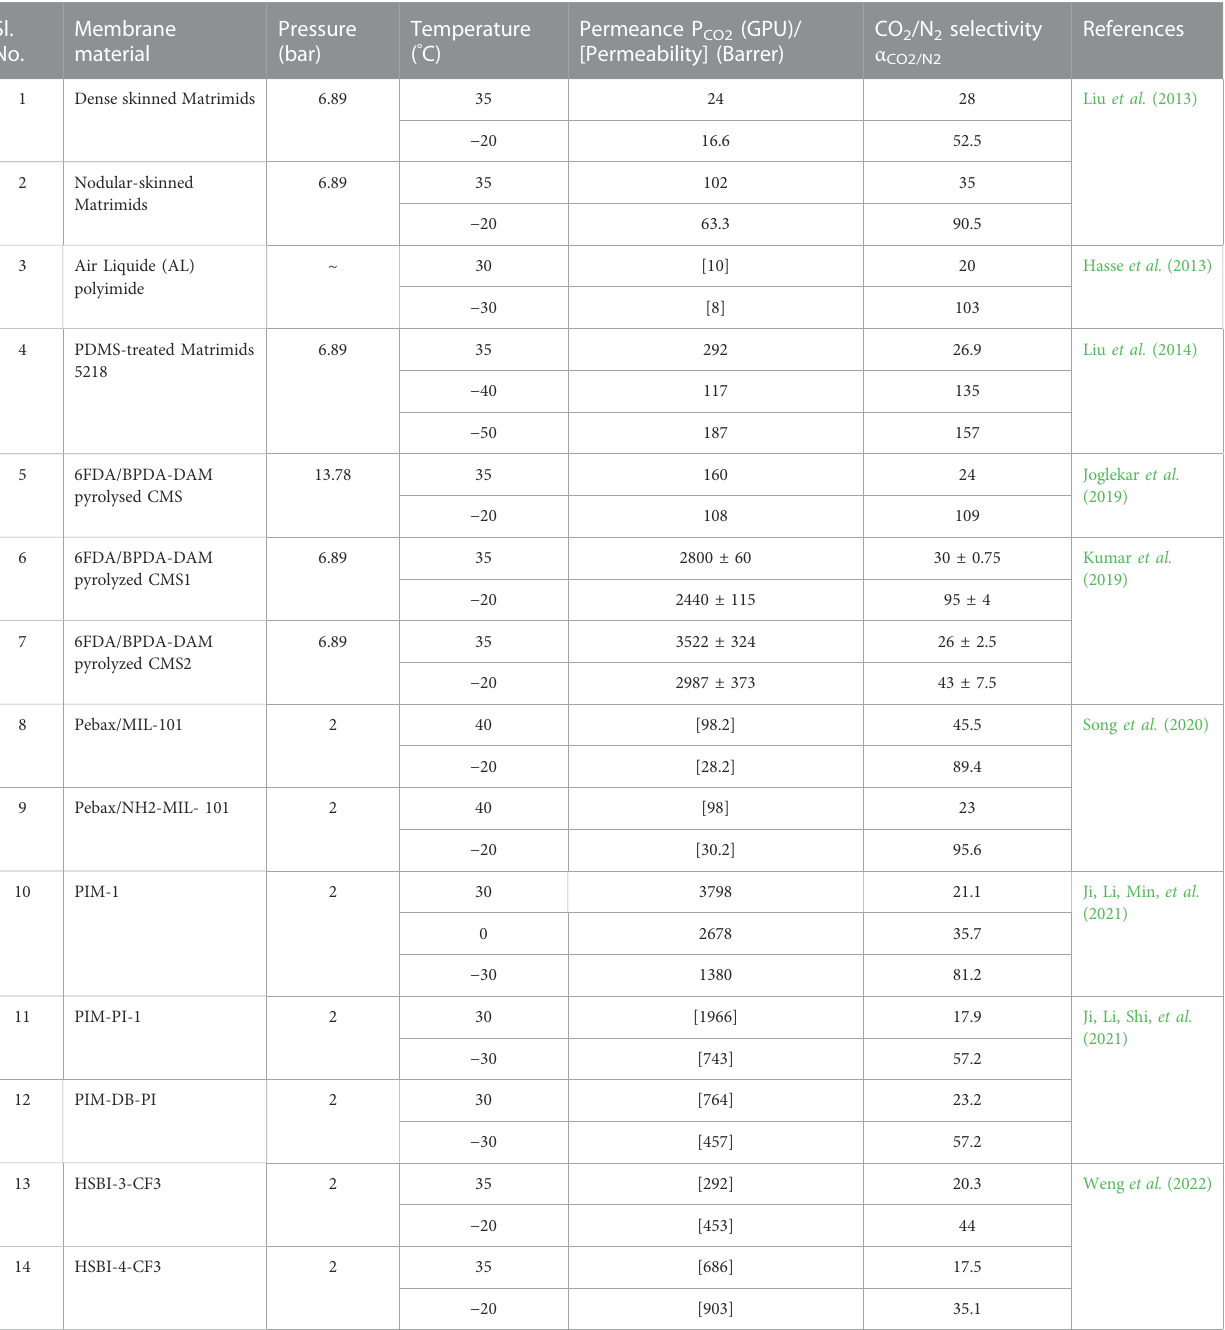
TABLE 3 Temperature dependant performance of membrane materials. Sl.